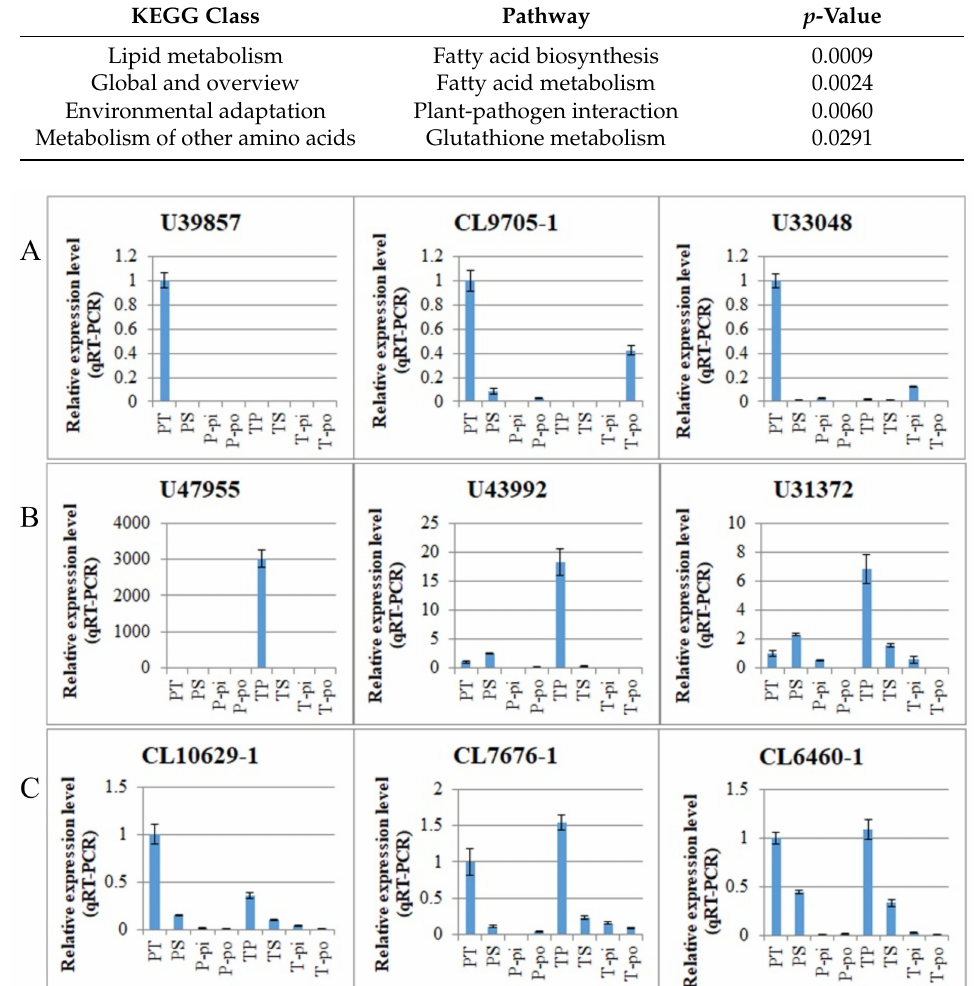
Table 4. KEGG terms enriched among downregulated DEGs in the PS vs. PT and TS vs. TP comparisons.